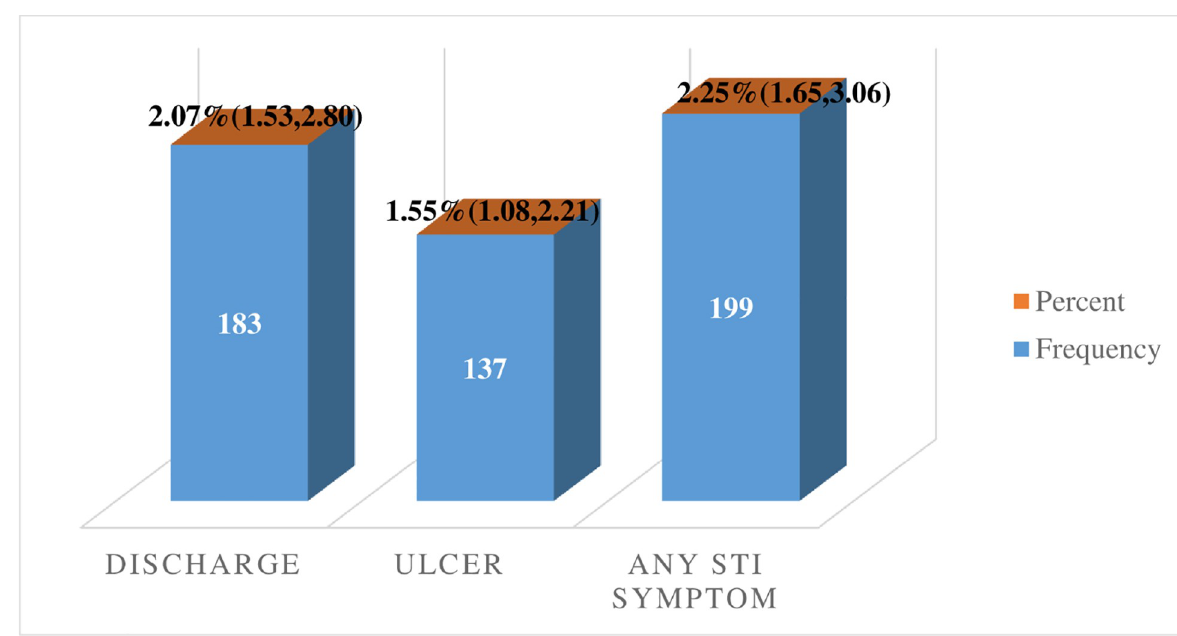
Fig 2. Types of STI syndromes among sexually active men in Ethiopia; 2016 EDHS.